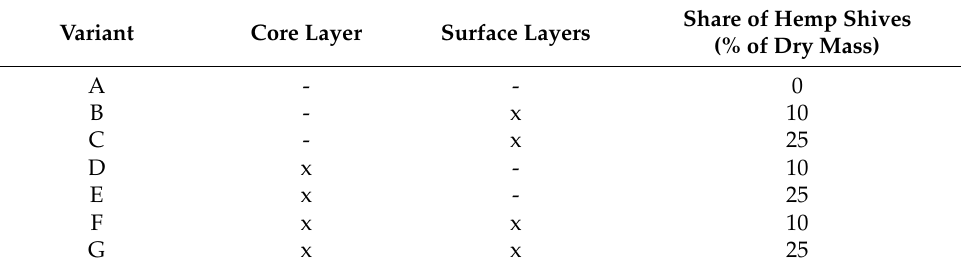
Table 2. Variants of manufactured